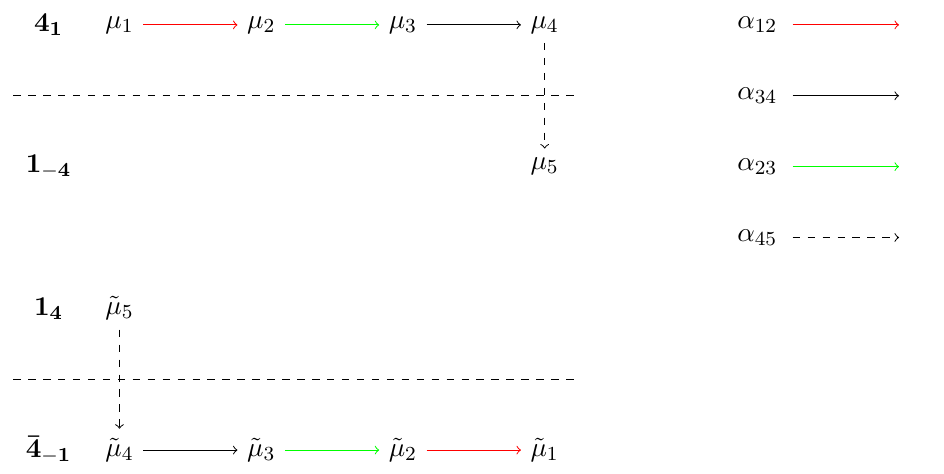
Figure 2 . Weight diagram of the fundamental 5 and the anti-fundamental (cid:22)5 representations of sl (5) with weights arranged into irreducible representations under the decomposition SL(5) ! SL(4) (cid:2) GL(1) when the root (cid:11) 45 is deleted. The highest weights here are (cid:22) 1 and ~ (cid:22) 5 respectively. The action of di(cid:11)erent roots is denoted by di(cid:11)erent colours and the direction of arrows shows the lowering of the weight.